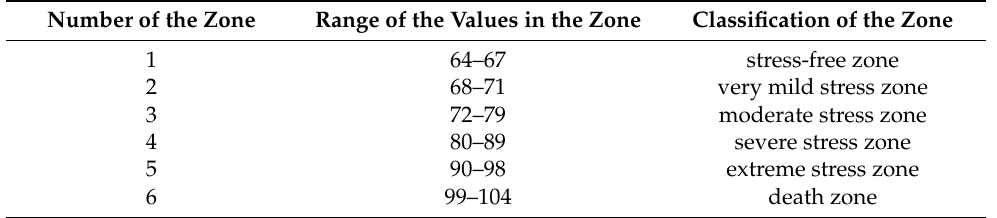
Table 2. Overview of the zones calculated according to the temperature-humidity index.